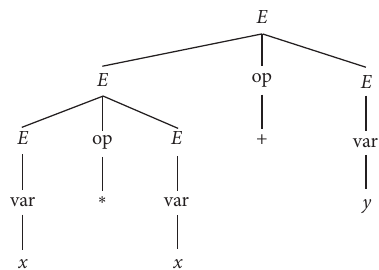
Figure 1: An example tree of an expression f ( x , y ) � x ∗ x + y